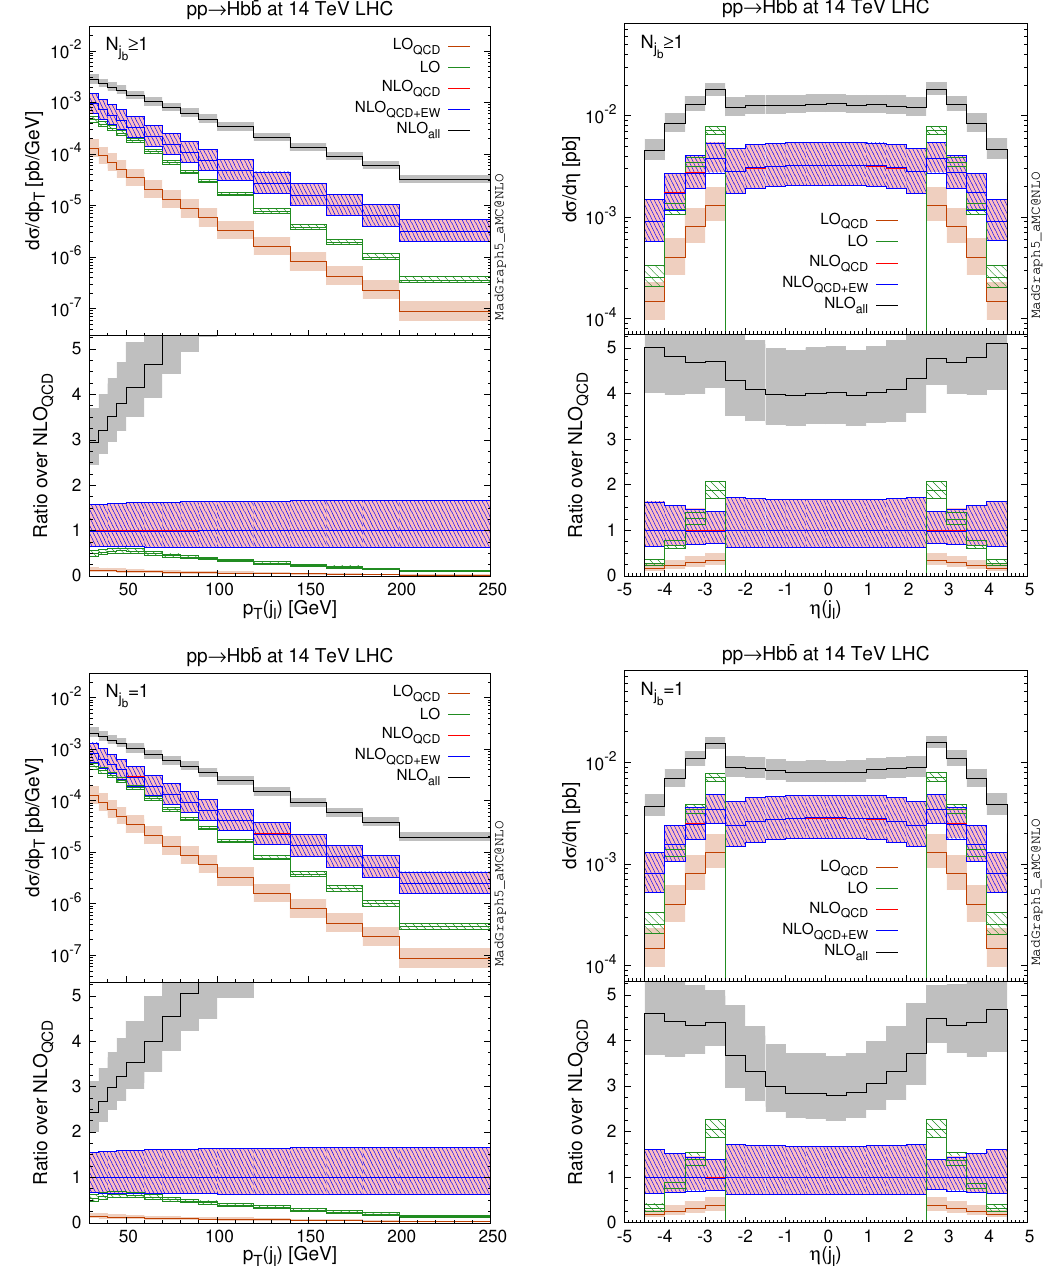
Figure 8 . The p T ( j l ) (left) and η ( j l ) (right) distribution for N j